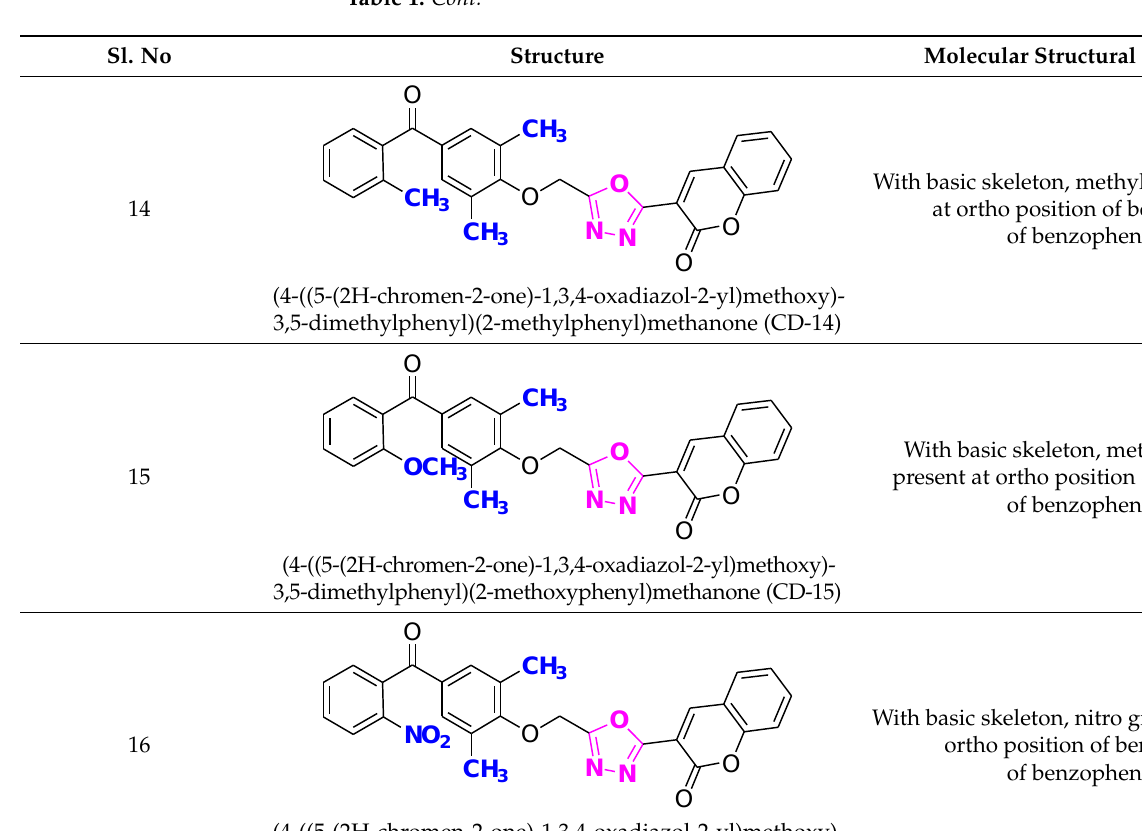
With basic skeleton, nitro group is present at ortho position of benzoyl ring of